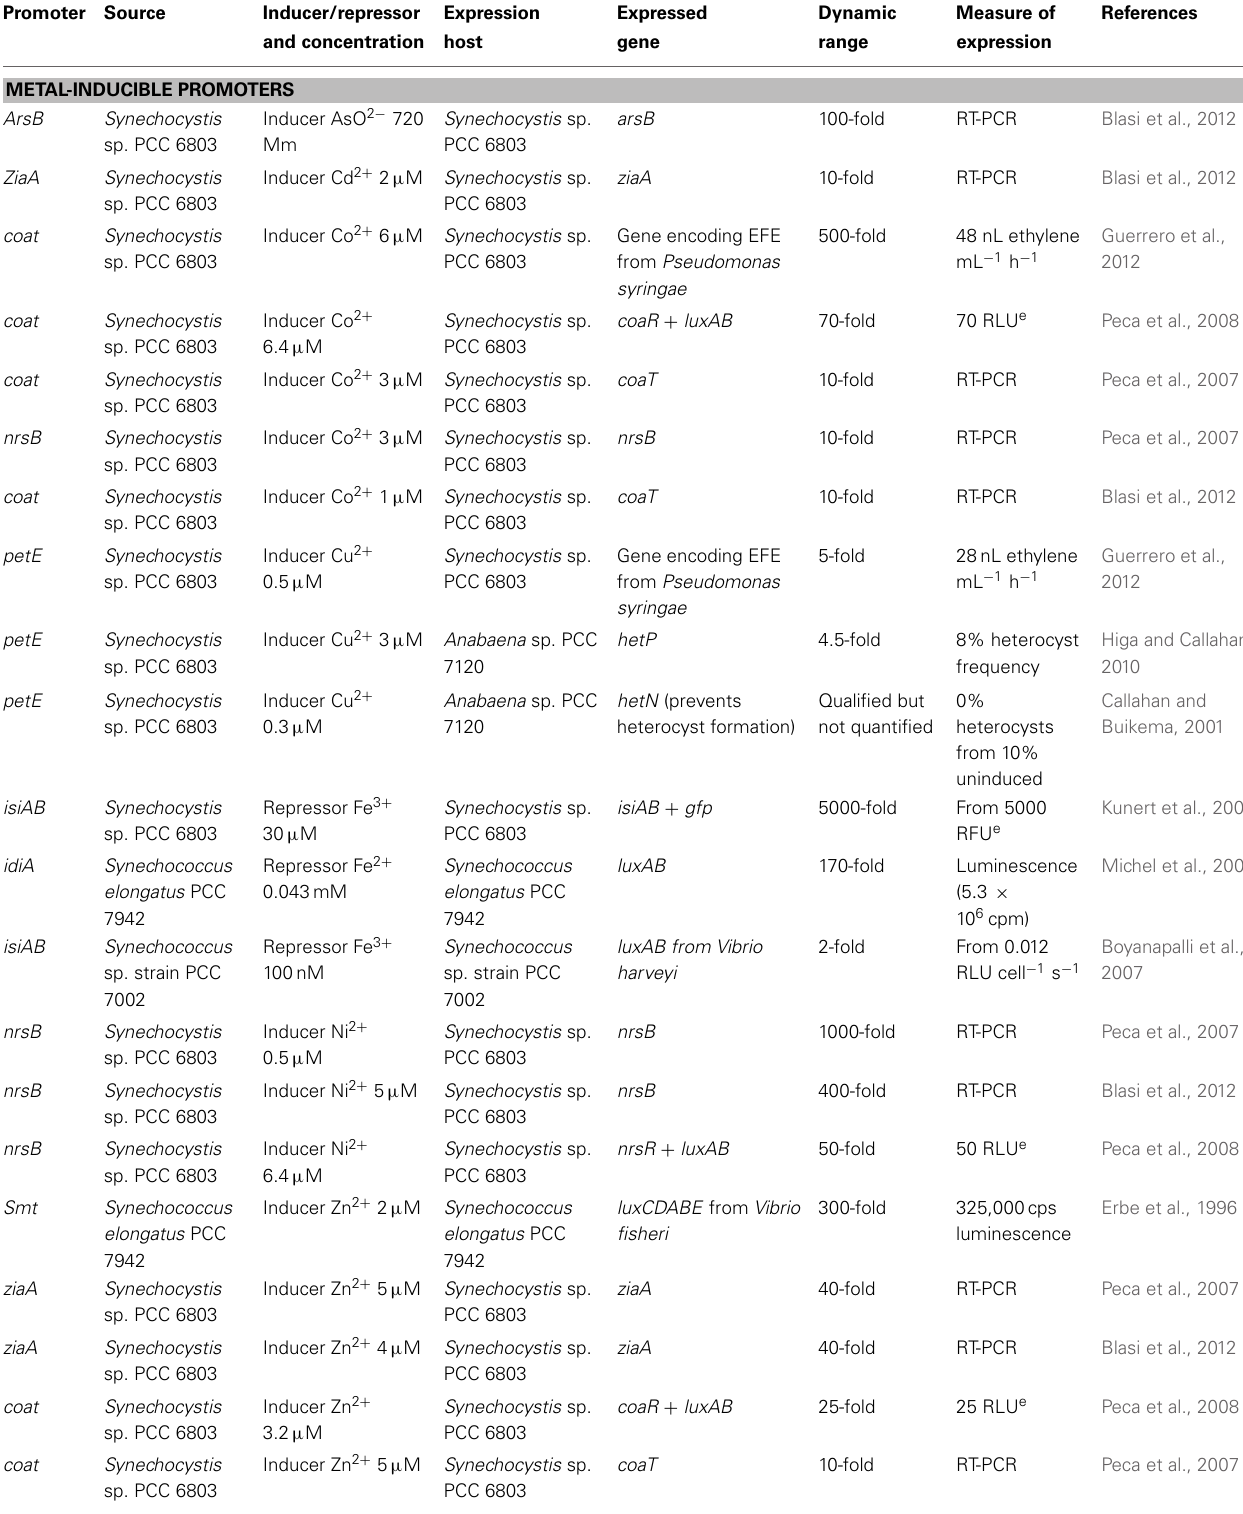
Table 2 | Inducible promoters used in cyanobacterial